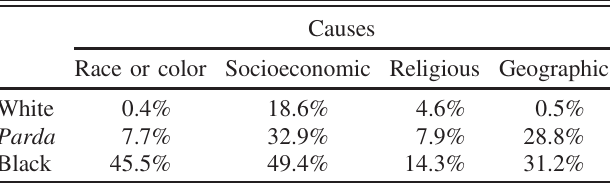
TABLE II. Percentage of people (within each group) that felt negative influence or discrimination due to the causes in the first